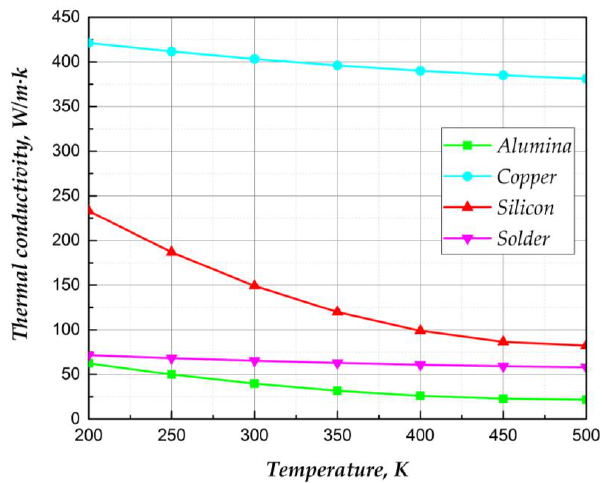
Figure 2. The relationship between thermal conductivity and temperature of different materials.